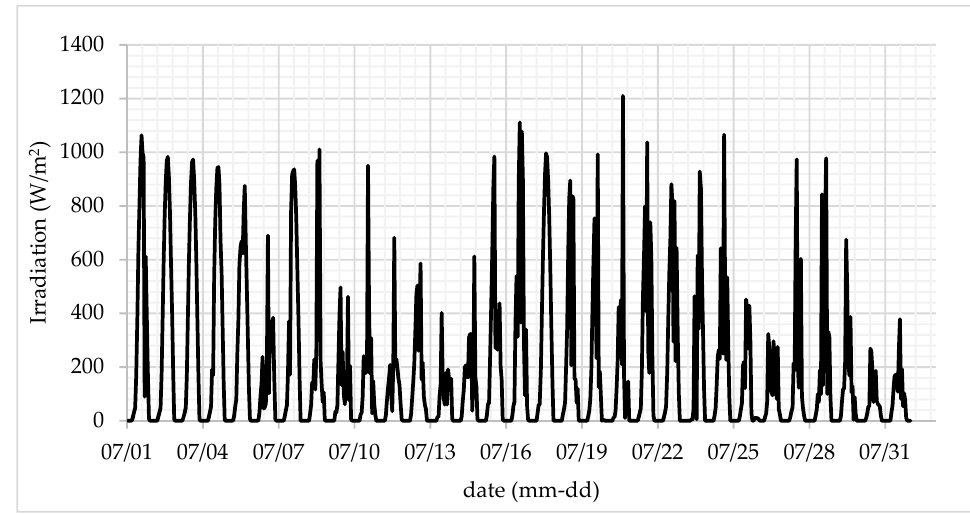
Figure 7. Irradiation measured in July 2015.